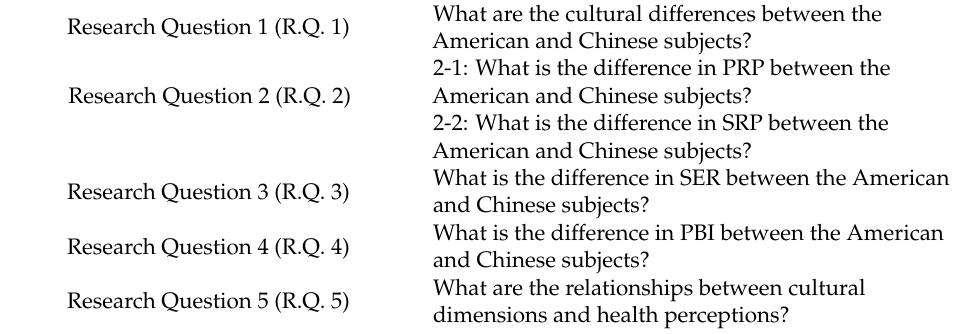
Table 3. Summary of research questions.